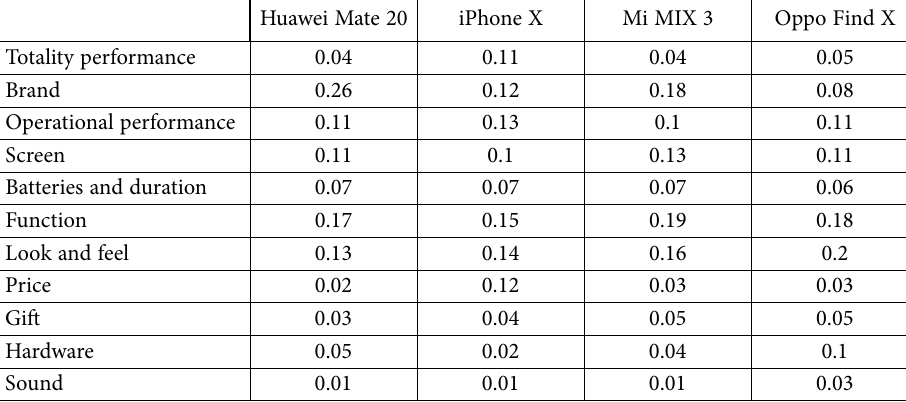
Table 4. Weight matrices of the 11 attributes for four phones on jd.com